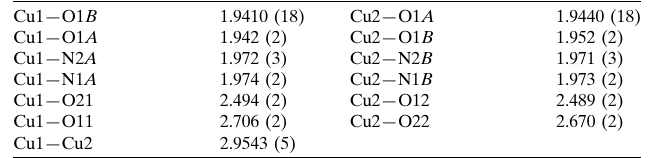
Selected bond lengths (A˚ ).